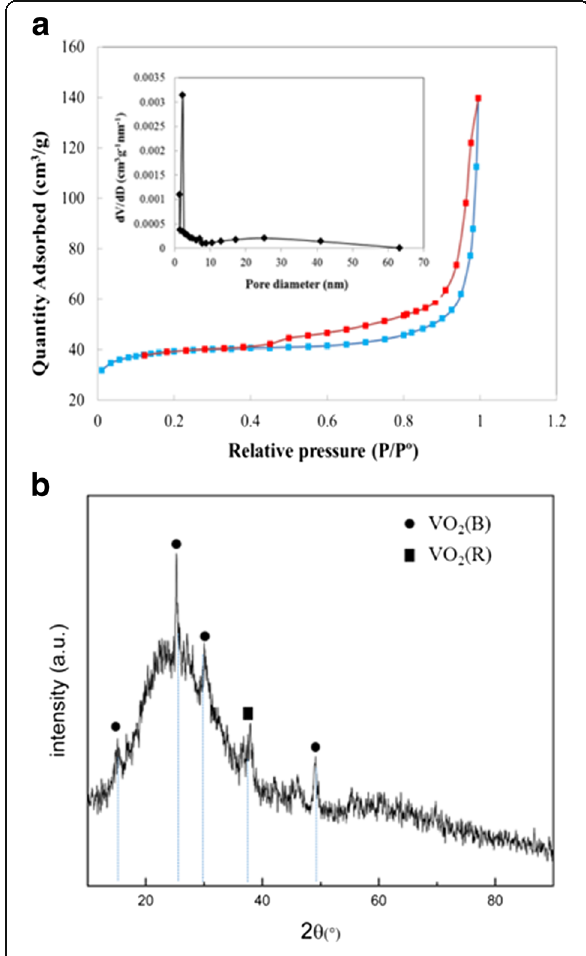
Fig. 2 N 2 adsorption – desorption isotherms with corresponding pore size distribution ( a ) and XRD pattern of 2D VO 2 microarrays ( b